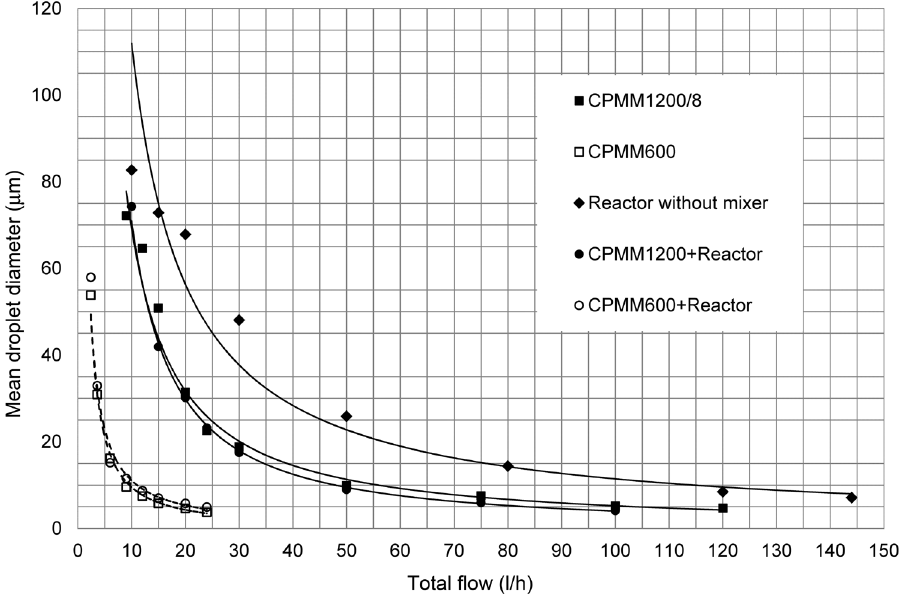
Figure 4 Comparison of the mean droplet diameter as function of the total volumetric flow using water (0.01 mol SDS)/heptane at a flow rate ratio of 5:1.